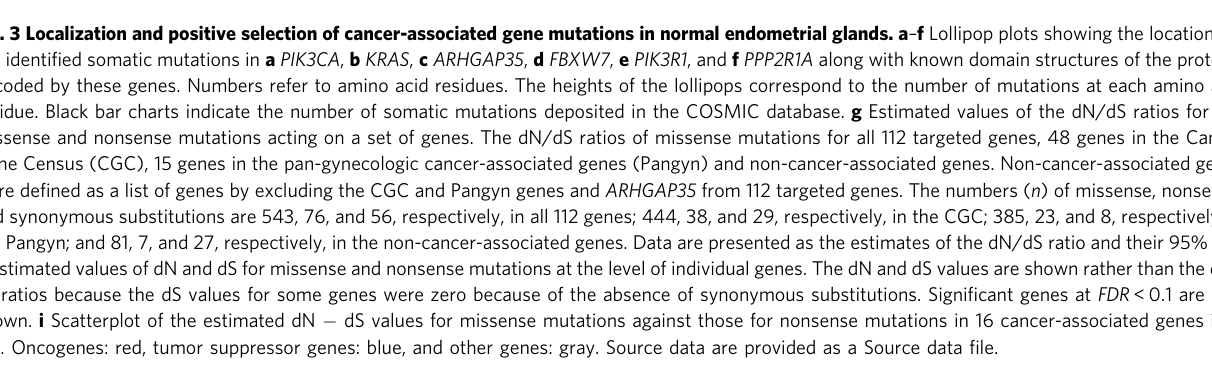
Fig. 3 Localization and positive selection of cancer-associated gene mutations in normal endometrial glands. a – f Lollipop plots showing the locations of encoded by these genes. Numbers refer to amino acid residues. The heights of the lollipops correspond to the number of mutations at each amino acid residue. Black bar charts indicate the number of somatic mutations deposited in the COSMIC database. g Estimated values of the dN/dS ratios